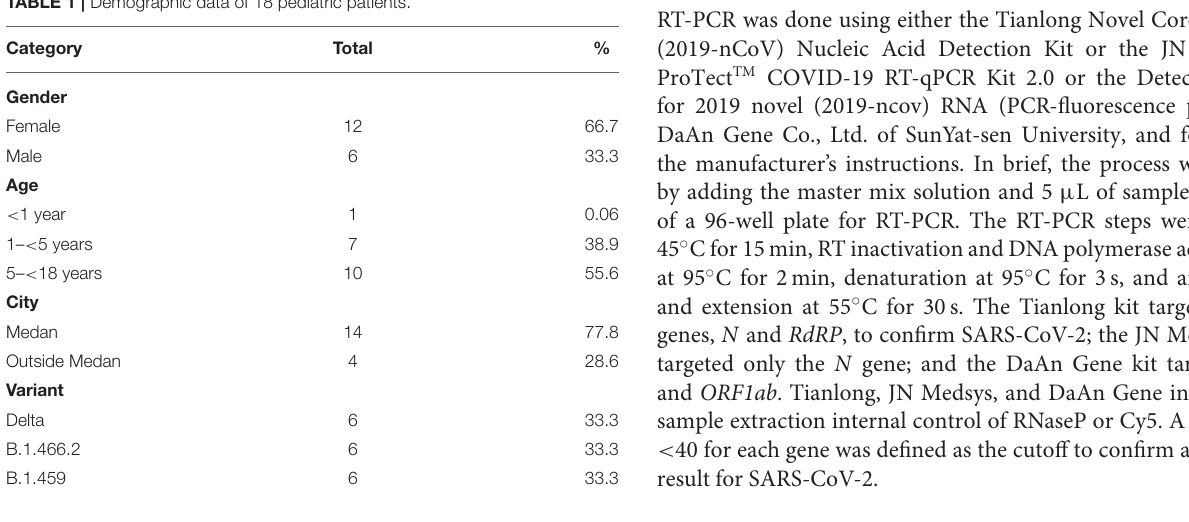
TABLE 1 | Demographic data of 18 pediatric patients.